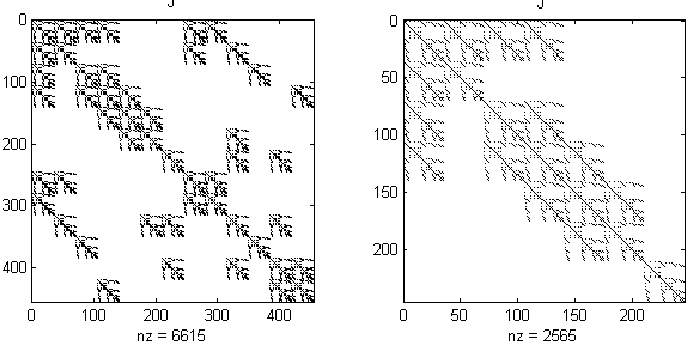
Figure 2. Structure of Jacobian matrix for IEEE 14-bus test system with D = 4 after decoupling. For ease of expression, N constant matrices r Φ 1 , . . . , Φ N s are constructed at N quadrature